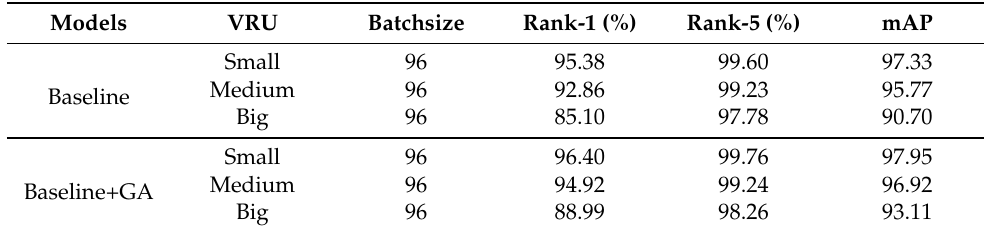
Table A3. Test results of the baseline model and the global attention model with input batch 96 on the VRU